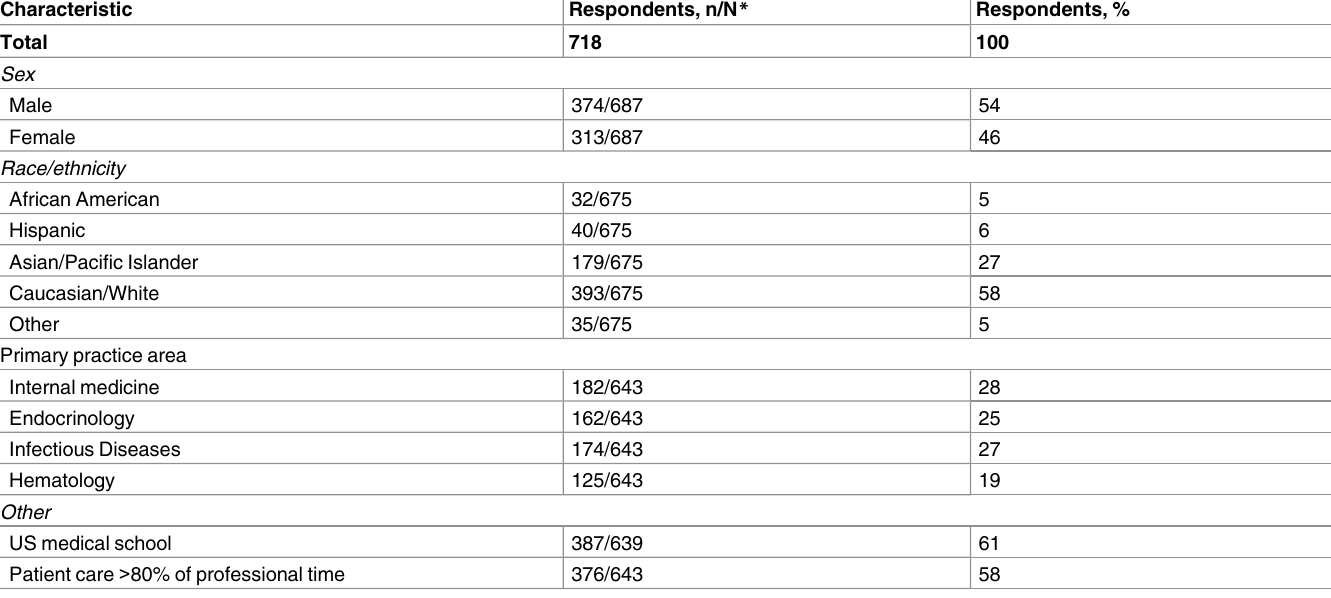
Table 1. Characteristics of survey